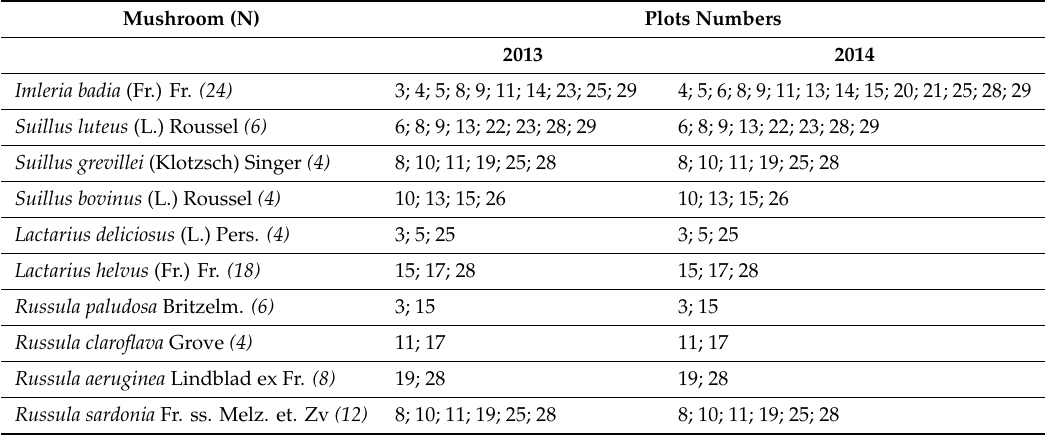
Table 2. Frequency and plot numbers with the collection of individual species of forest mushrooms in 2013 and